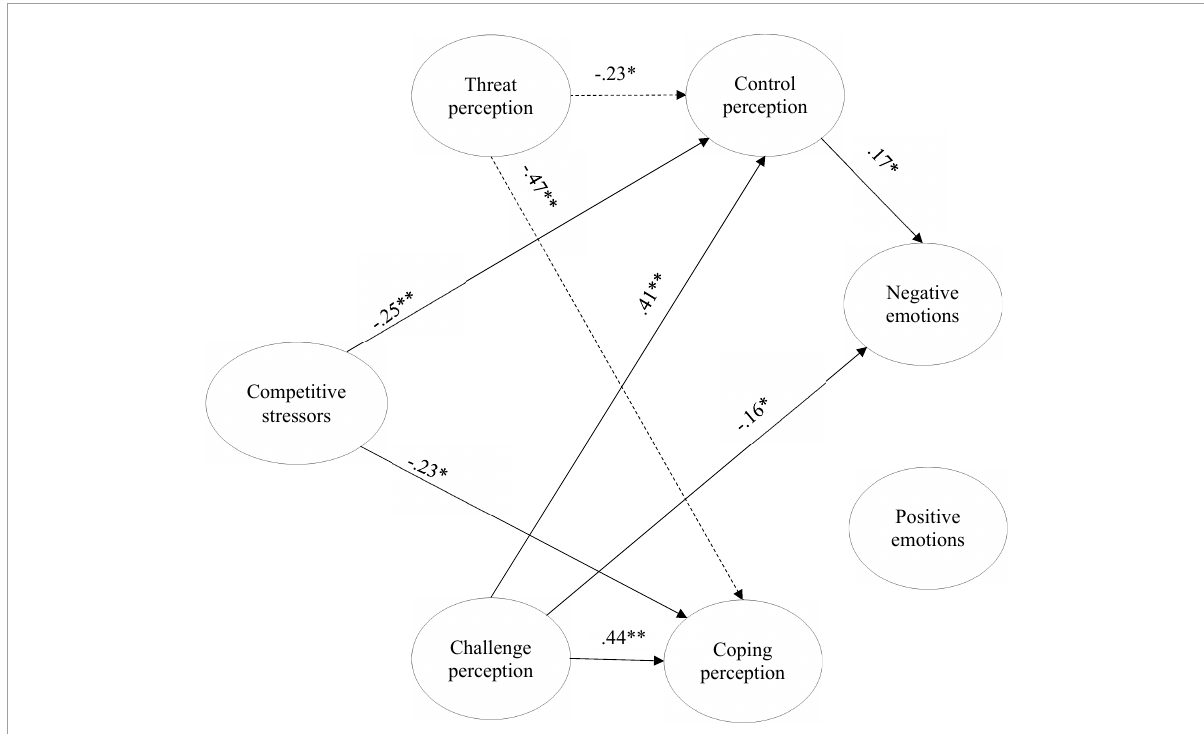
FIGURE5 Partial mediation model: comparison among groups. The dashed arrows represent the U17, and the arrows the U19. * p < 0.05; ** p < 0.01; only significantly different paths among groups are